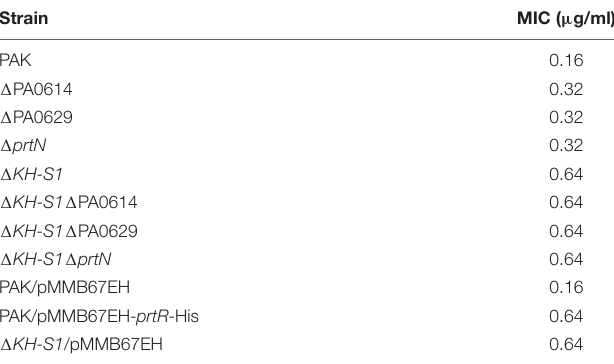
TABLE 3 | Bacterial susceptibilities to ciprofloxacin.